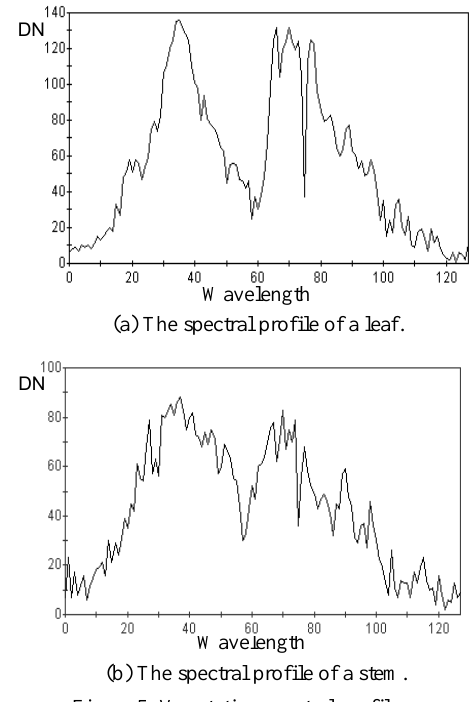
Figure 5. Vegetation spectral